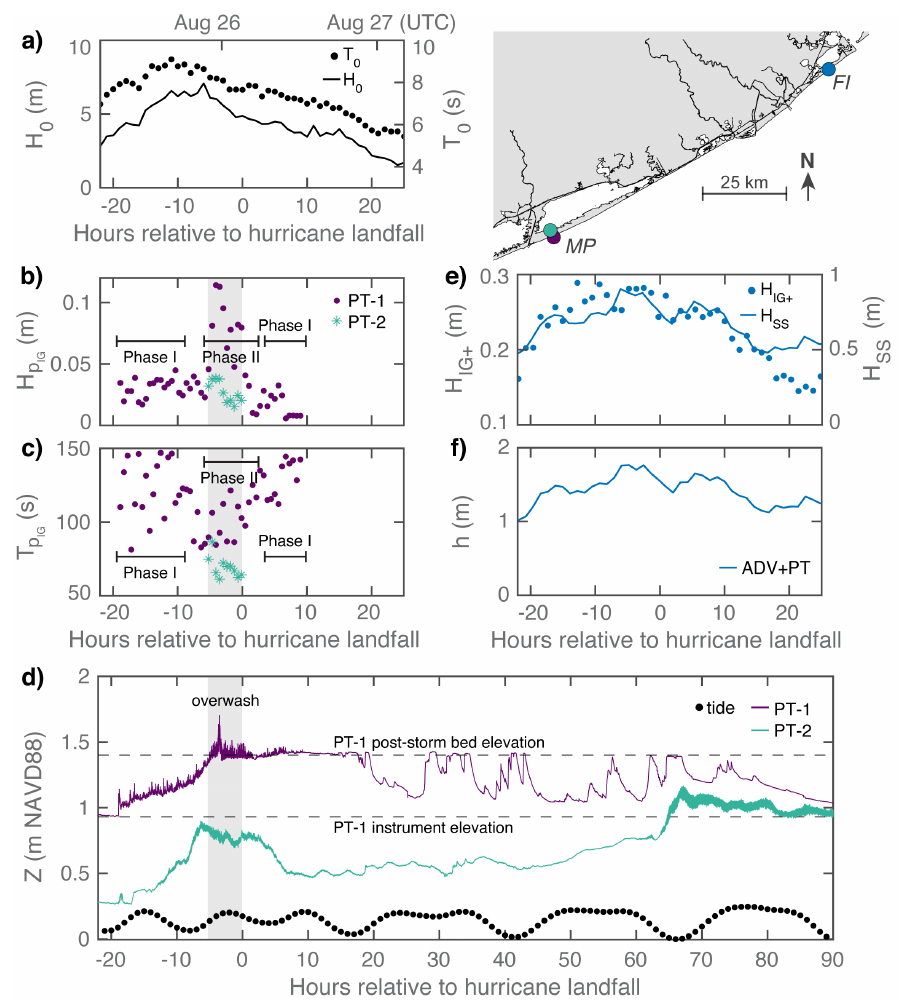
Figure 2. Hydrodynamic conditions measured during Hurricane Harvey ( a ) offshore (data from National Data Buoy Center (NDBC) Station 42019, 82 m water depth), ( b – d ) in the backshore (PT-1) and back barrier (PT-2) at Matagorda Peninsula (MP), and ( e , f ) in the surf zone (ADV+PT) at Follets Island (FI). Bulk statistics include ( a ) deep-water significant wave height H 0 and mean spectral wave period T 0 ; ( b – c ) mean spectral period T P and height H P of pressure head in the IG frequency band; IG IG ( e ) incoming IG significant wave height H IG + and sea-swell significant wave height H SS ; ( f ) mean water depth h ; and ( d ) pressure head referenced to NAVD88 ( Z , referenced using post-storm PT elevations). The gray shaded region in ( b – d ) corresponds to the time period of overwash and Phase I and Phase II reference different periods of groundwater dynamics (see Figure 4). The difference between the dashed lines in ( d ) denotes the estimated bed-level change at PT-1 from post-storm reconnaissance (i.e., 47